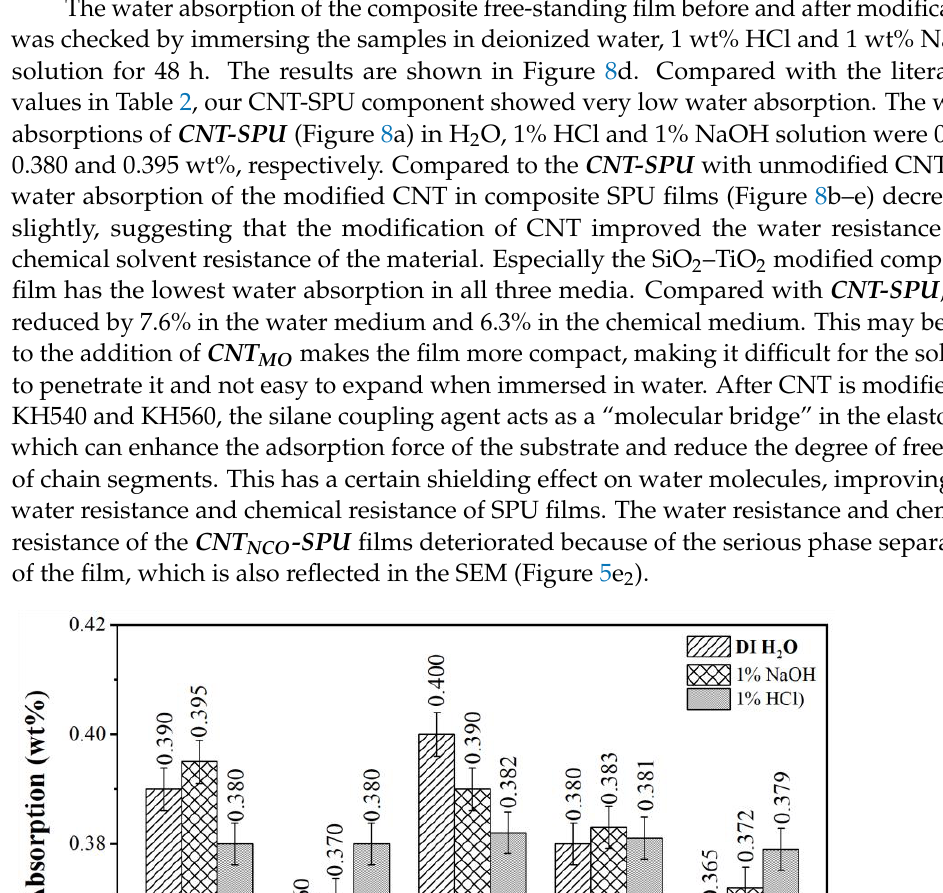
Table 2. Summary of mechanical properties and water absorption of SPU.